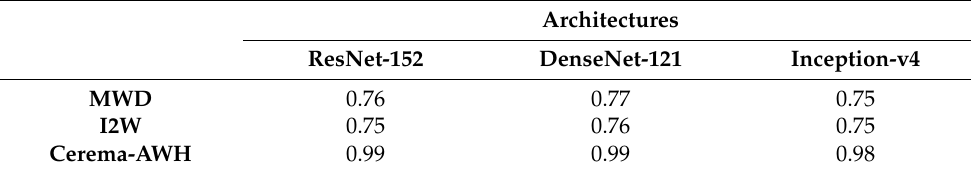
Table 7. Classification comparison on 3 different databases with 3 meteorological classes.